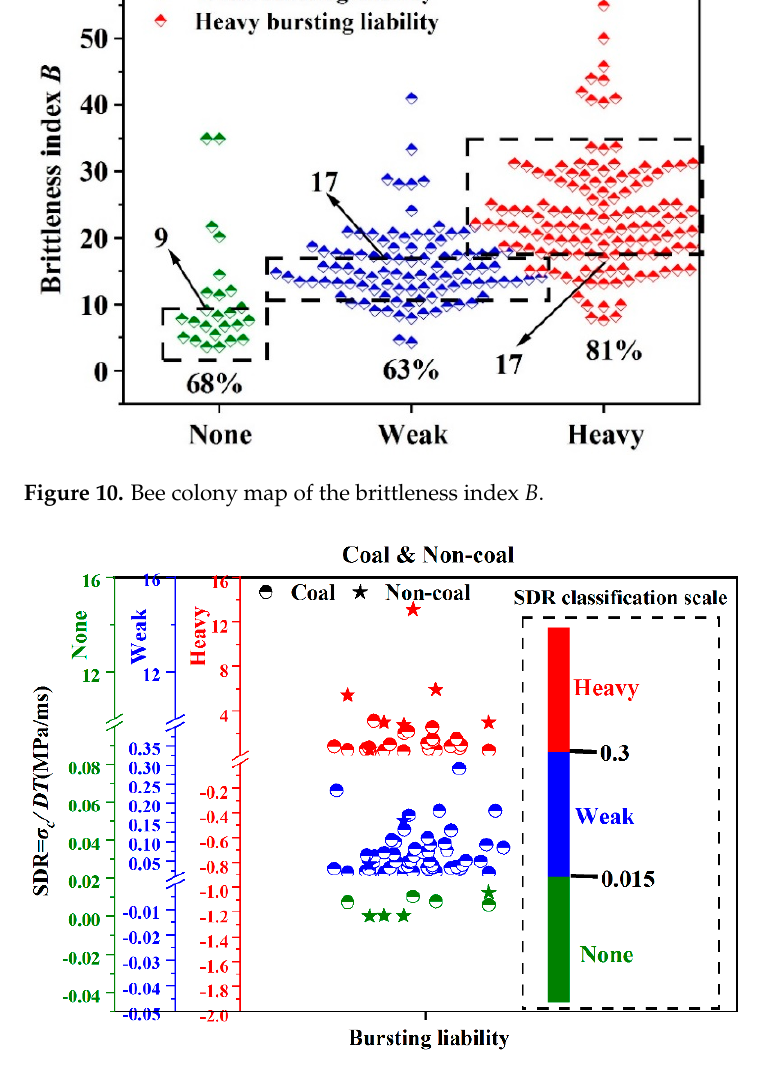
Figure 11. Distribution and classification scale of strength decrease rates ( SDR s) of coal and non- coal rocks.